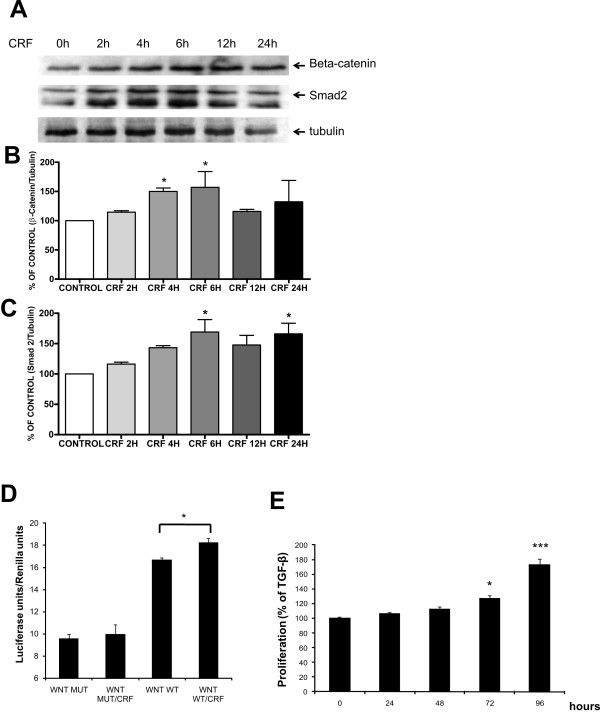
CRF induced the expression of β-catenin and SMAD2. Western blot analysis were performed as described in Materials and methods in order to asses the effect of CRF on β-catenin and SMAD2 expression at protein levels. CRF significantly induced the expression of β-catenin (A,B) at 4 and 6 h whereas the expression of SMAD2 (A, C) was significantly induced at 6, and 24 h. Data are expressed as MEAN ± SEM of five independent experiments. * p < 0.05 compared to untreated control. D. 4T1 cells were transfected with a luciferase construct containing a WNT-responsive element in which the complex of β-catenin and Tcf binds. Cells were stimulated with CRF and luciferase activity was measured in cell lysates 24 hours following stimulation. Data are expressed as MEAN ± SEM of three independent experiments (*p < 0.05). E. 4T1 cells were stimulated with TGFβ at 5 ng/ml in the presence or absence of CRF at 10-8M and proliferation was measured using the MTT assay. Data are expressed as MEAN ± SEM of three independent experiments. * p < 0.05 compared to TGFβ -only treated cells.